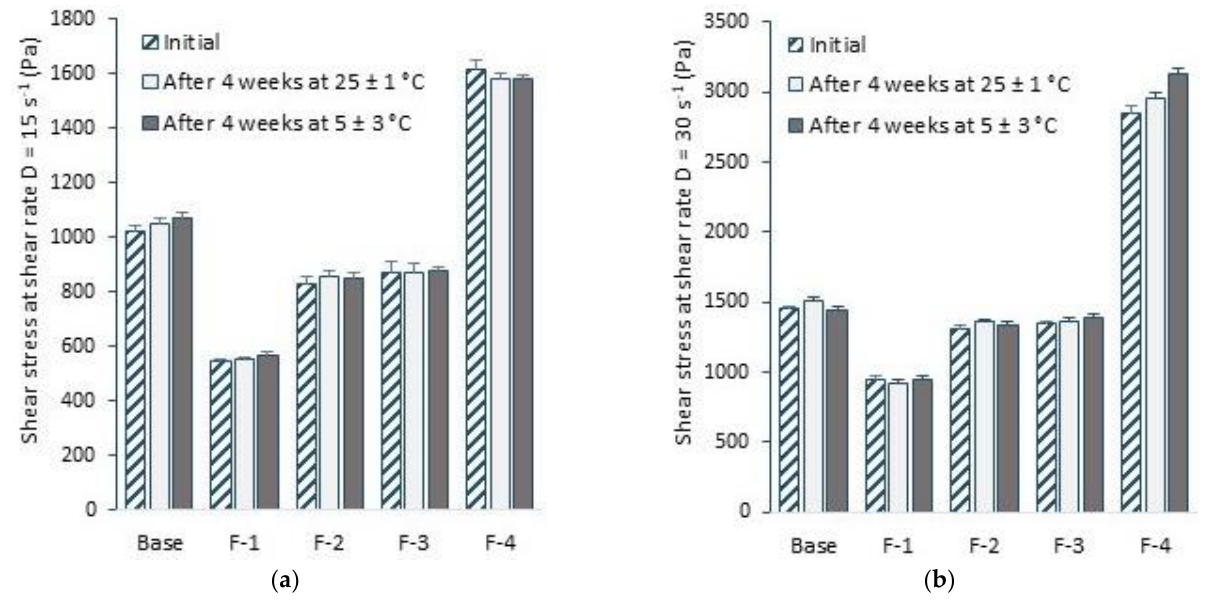
Figure 6. Shear stress values of the tested formulations after preparation (initially) and after 4 weeks of storage at different temperatures, measured at two different shear rates: ( a ) D = 15 s −1 ; ( b ) D = 30 s −1 .